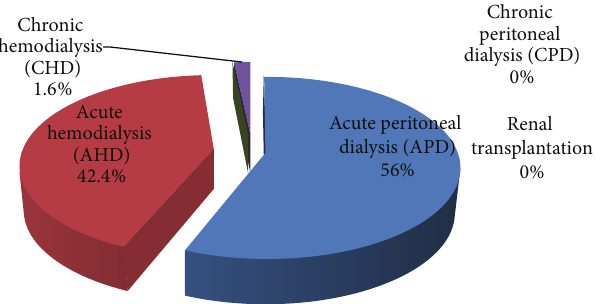
Figure 3: Modality of RRT accessed by patients.